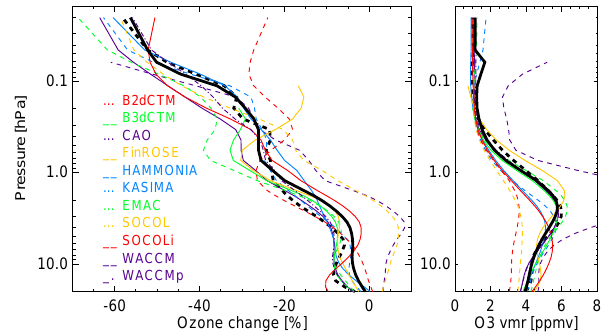
Fig. 27. Area-weighted averages (70–90 ◦ N) of observed and mod- eled relative O 3 changes during 29 October–4 November (left) with respect to the abundances on 26 October (right). Thick solid and dashed lines represent multi-model mean average and MIPAS ob- servations, respectively. WACCMp denotes the WACCM simula- tion including proton ionization, only (excluded from the multi- model mean).